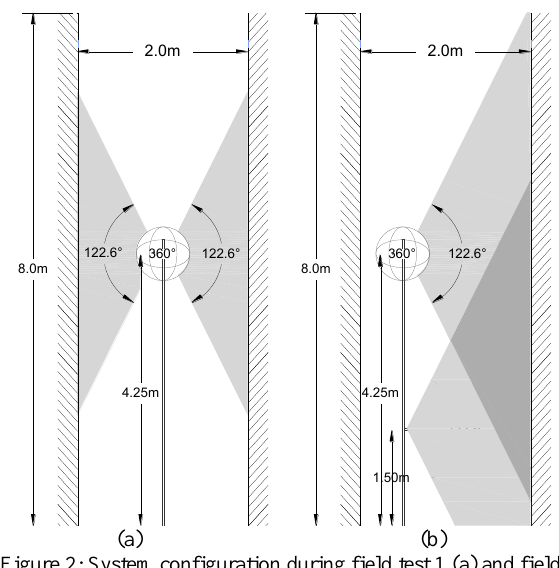
Figure 2: System configuration during field test 1 (a) and